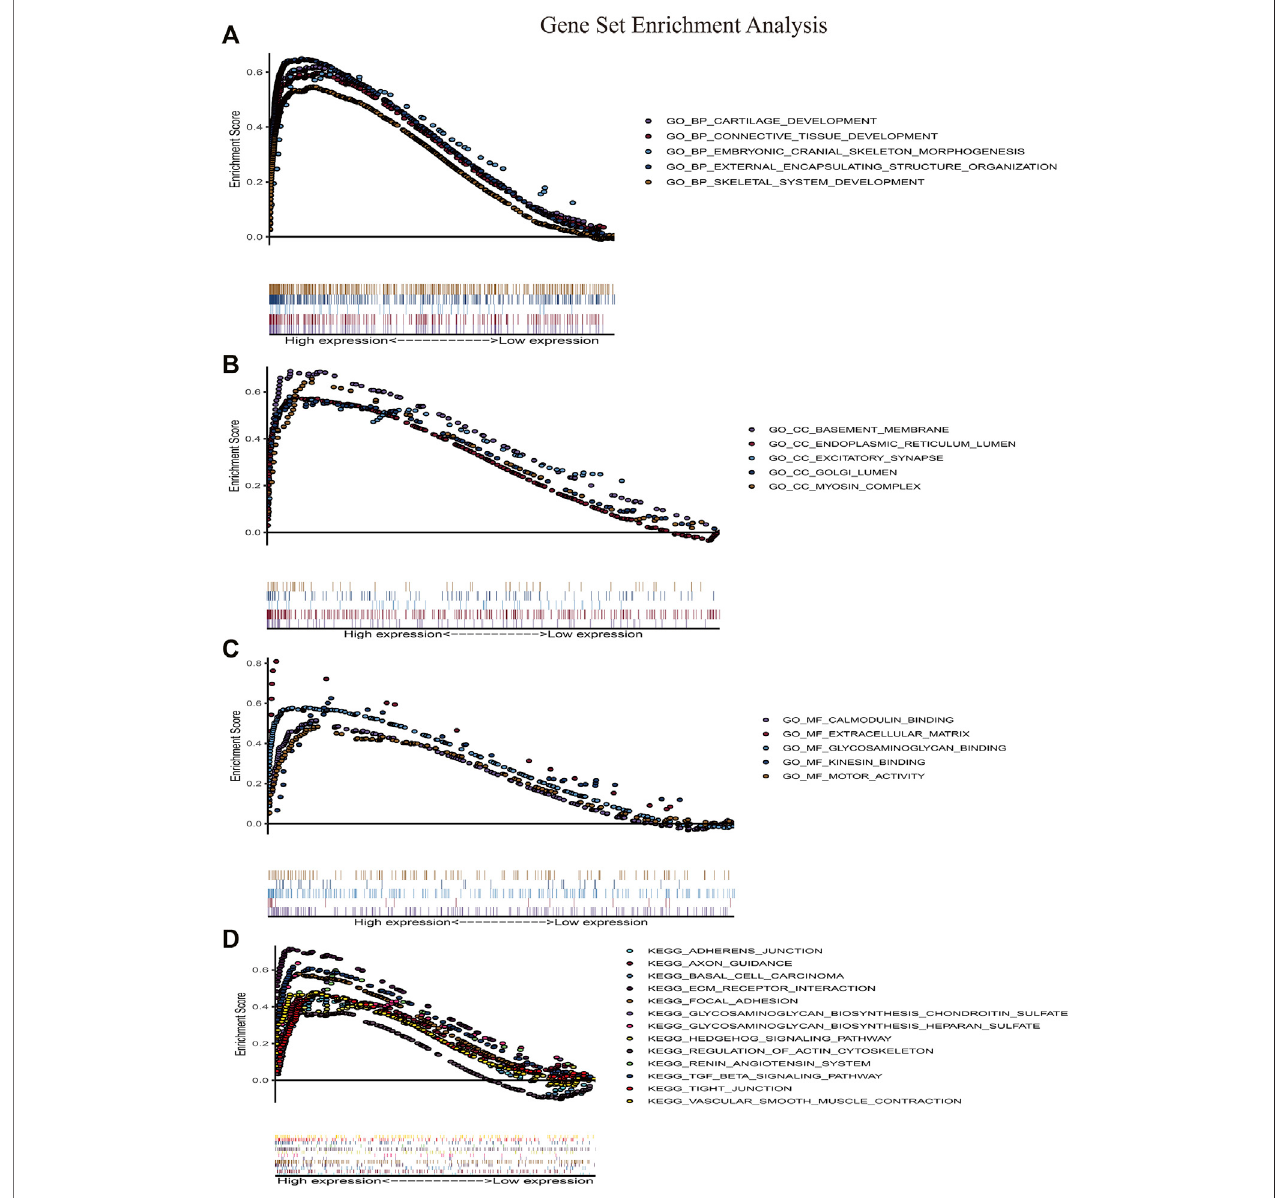
FIGURE 7 | Gene set enrichment analysis. (A – C) Gene ontology enrichment analysis. (D) KEGG pathway enrichment analysis. HCM, hypertrophic cardiomyopathy.